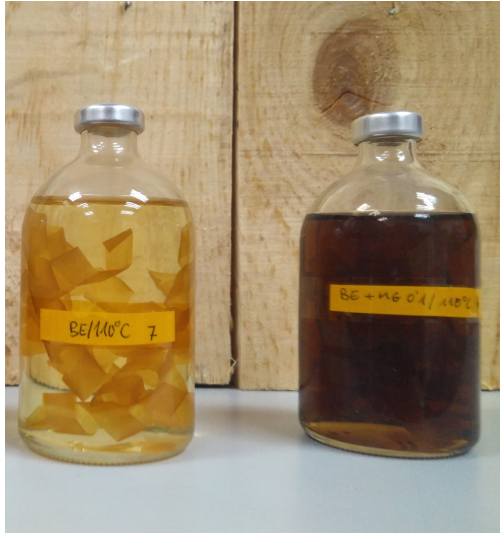
Figure 1. NF and NE aging test